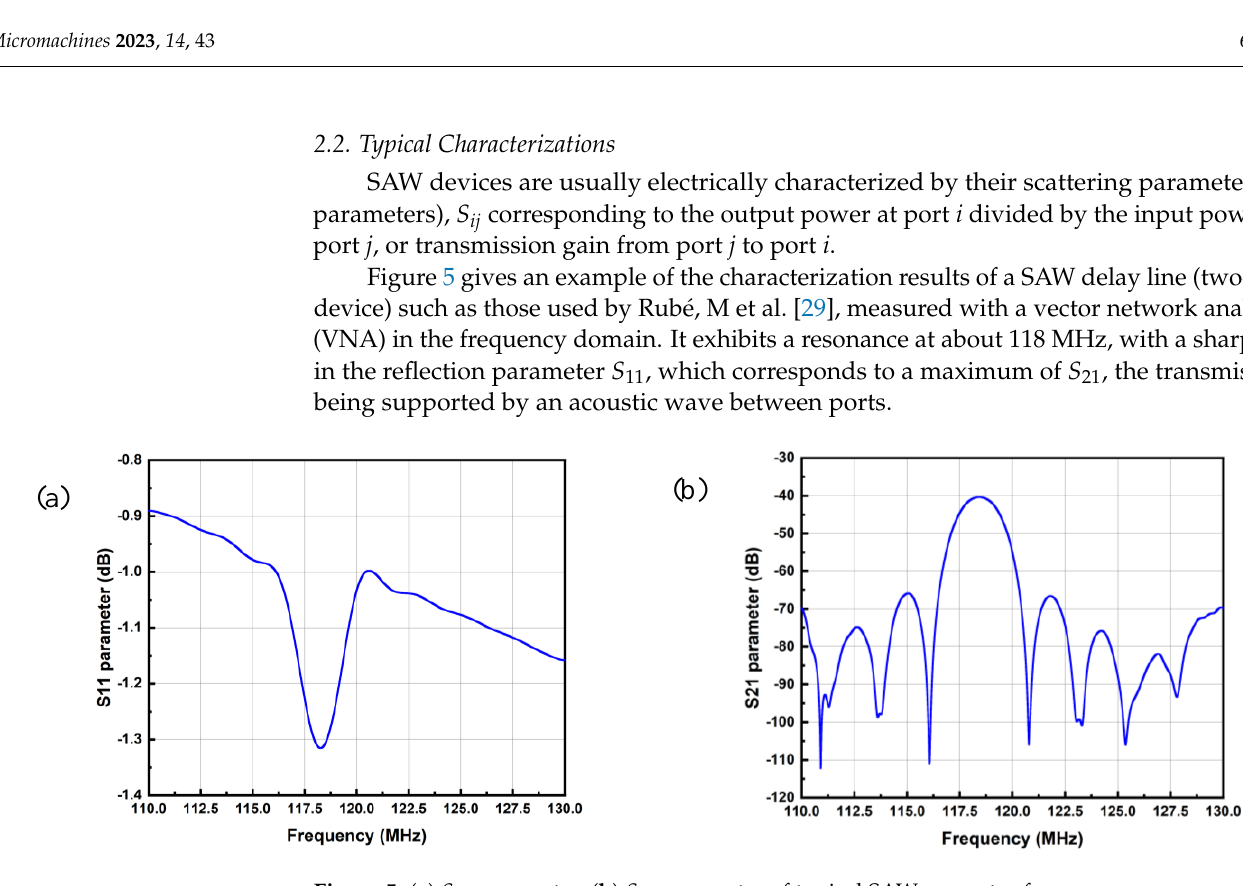
Figure 5. (a) 𝑆 11 parameter; (b) 𝑆 21 parameter of typical SAW resonator frequency response.